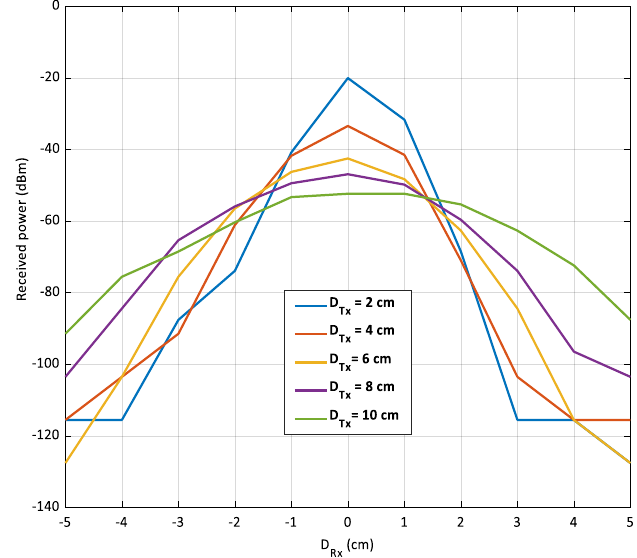
Figure 16. Stress test for Case A ( P in = 5 dBm, R L = 0.6 k Ω ).